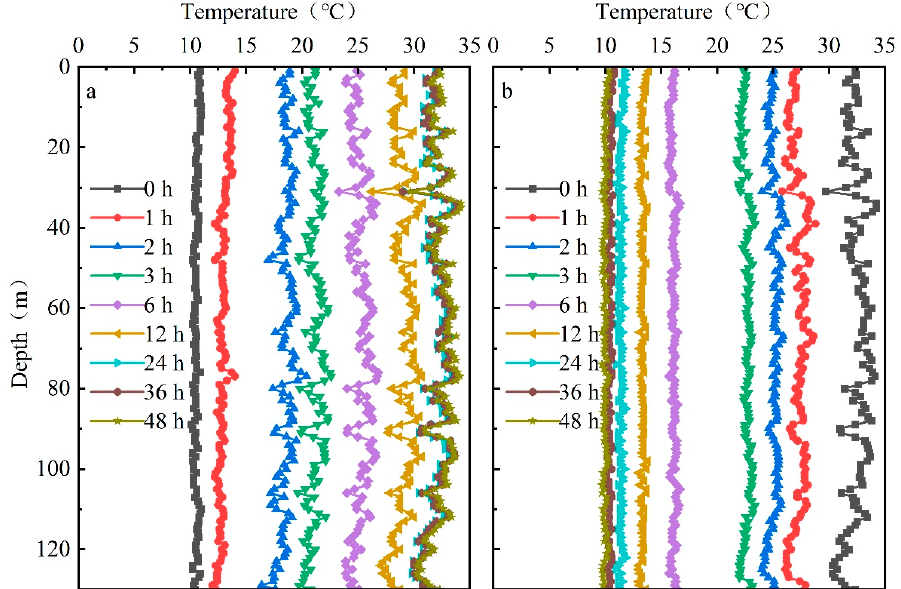
Figure 7. Temperature distribution in the borehole under different time nodes. ( a ) Working condi- tion A. ( b ) Ground temperature recovery after working condition